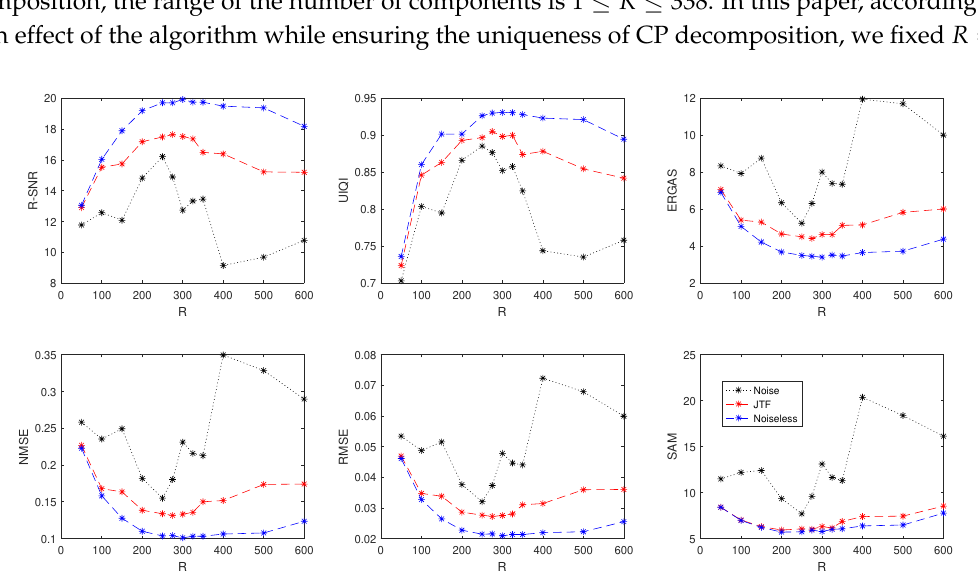
Figure 4. The results of evaluation metrics as functions of the number of components R for the proposed JTF method. UIQI, universal image quality